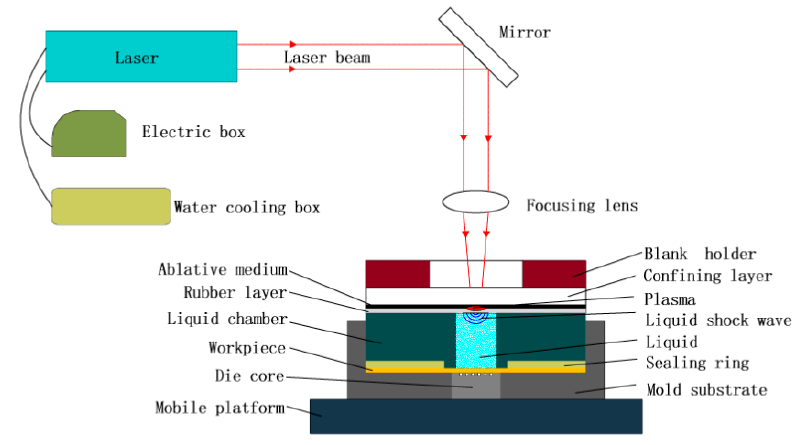
Figure 1. Schematic of the laser impact liquid flexible embossing process.